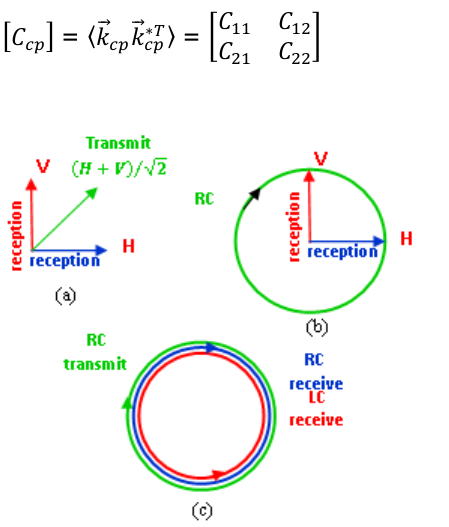
Table 2: Jones vector for canonical polarization states Polarization cases Figure 2: The three configurations of the compact polarimetry (a) π/ 4 , (b) CTLR and (c) DCP.